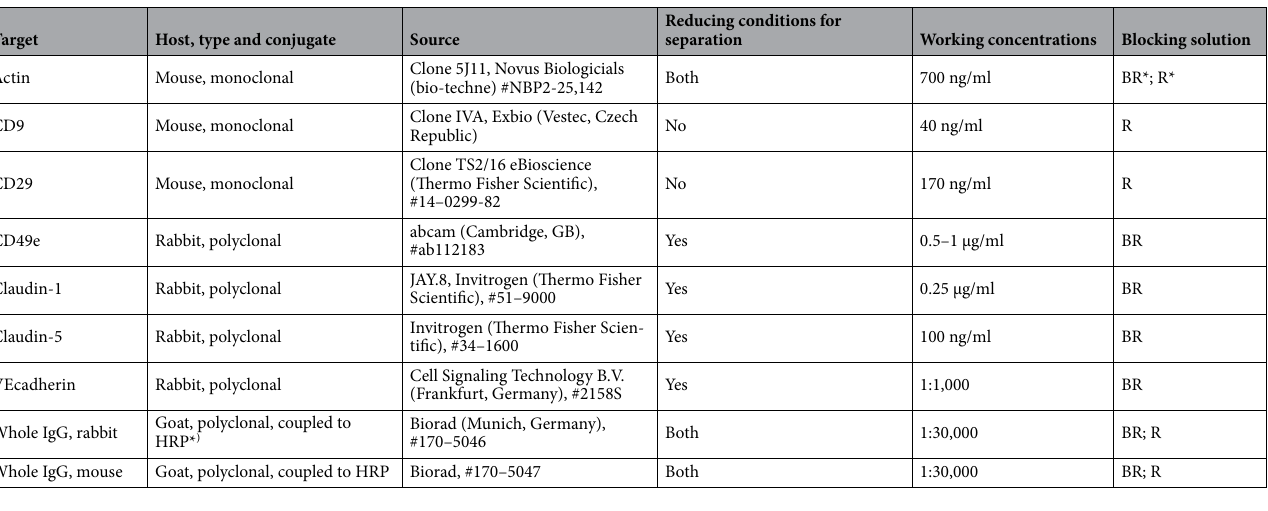
Table 2. Primary and secondary antibodies used. *BR: 1% blocking reagent (#11,096,176,001, Merck) with 0.1% Tween-20 (Biorad) in phosphate buffered saline without Ca 2+ /Mg 2+ , R 1% RotiBlock (#A151, Carl Roth, Karlsruhe), HRP horseradish